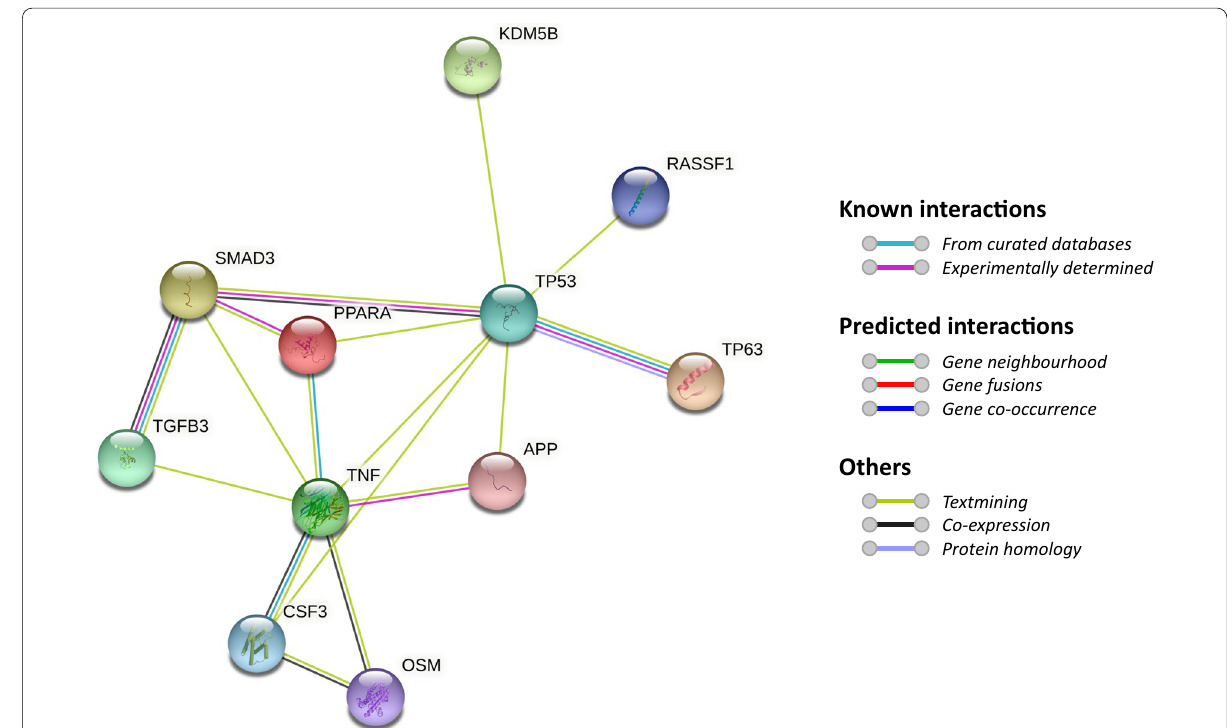
Fig. 7 Protein–protein interaction network of the top upstream regulators with the most significant DE